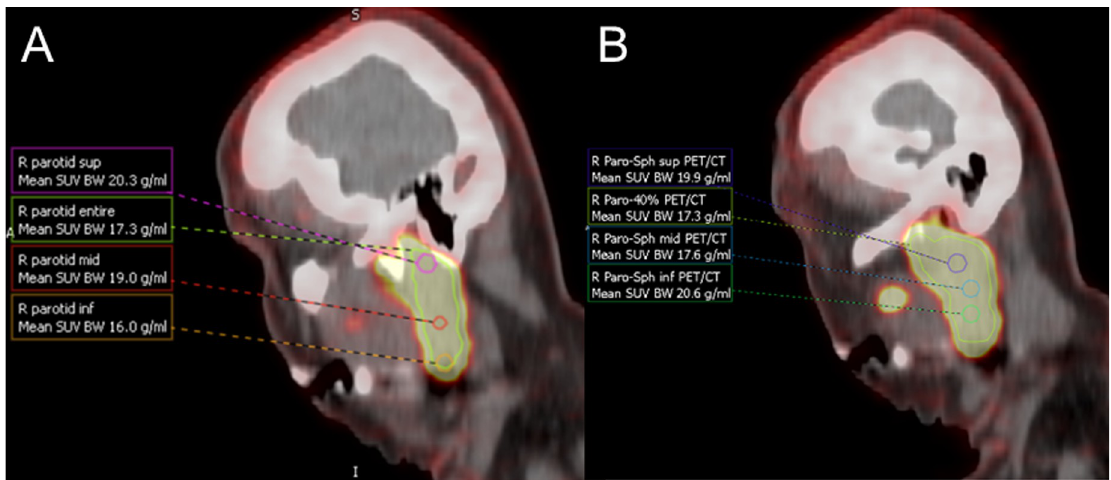
Fig 3. Example demonstrating variability for parotid region of interests (ROIs). Sagittal maximum intensity projection from the PET/ MR [ 18 F]DCFPyL PSMA tracer acquisition with labeled parotid gland and liver ROIs. Spatial variability of calculated SUV mean for the 1-cm ROIs obtained from the superior (sup), middle (mid), and inferior (inf) right parotid gland is seen with values of 18.6, 22.4, and 21.0 g/mL respectively.